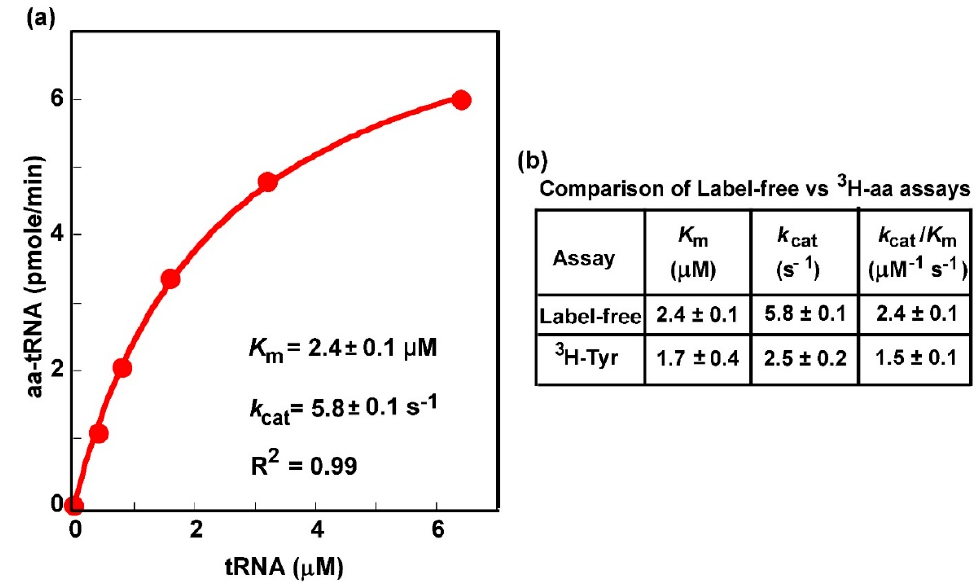
Figure 4. Michaelis–Menten kinetics of aminoacylation as monitored by the label-free biotin-SA conjugation assay. ( a ) A plot of the initial rate of aminoacylation as a function of the concentration of the tRNA substrate, which was the overrepresented E. coli tRNA Tyr / QUA in the presence of the entire pool of E. coli tRNAs. Data were fit to the Michaelis–Menten equation to generate the hyperbolic plot to derive the value of K m (tRNA) and k cat , showing an R 2 of 0.99. ( b ) A comparison of kinetic parameters between the label-free assay as derived in ( a ) and the traditional assay with [ 3 H]-Tyr as reported previously